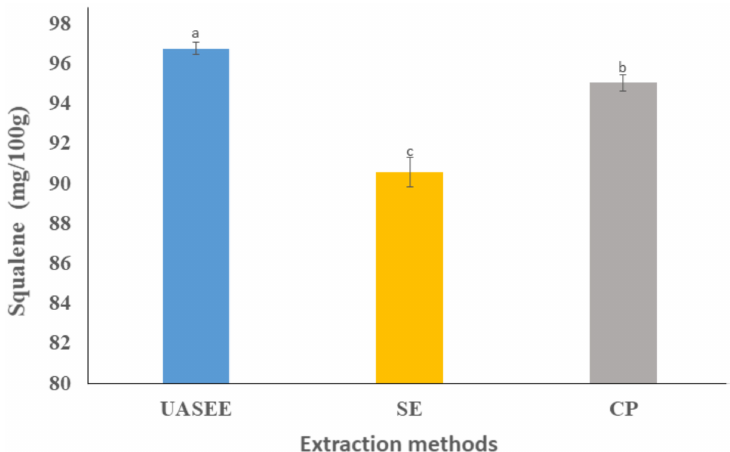
Figure 1. Squalene content of E. mollis oil obtained by different extraction methods. Different letters represent a significant difference at p <